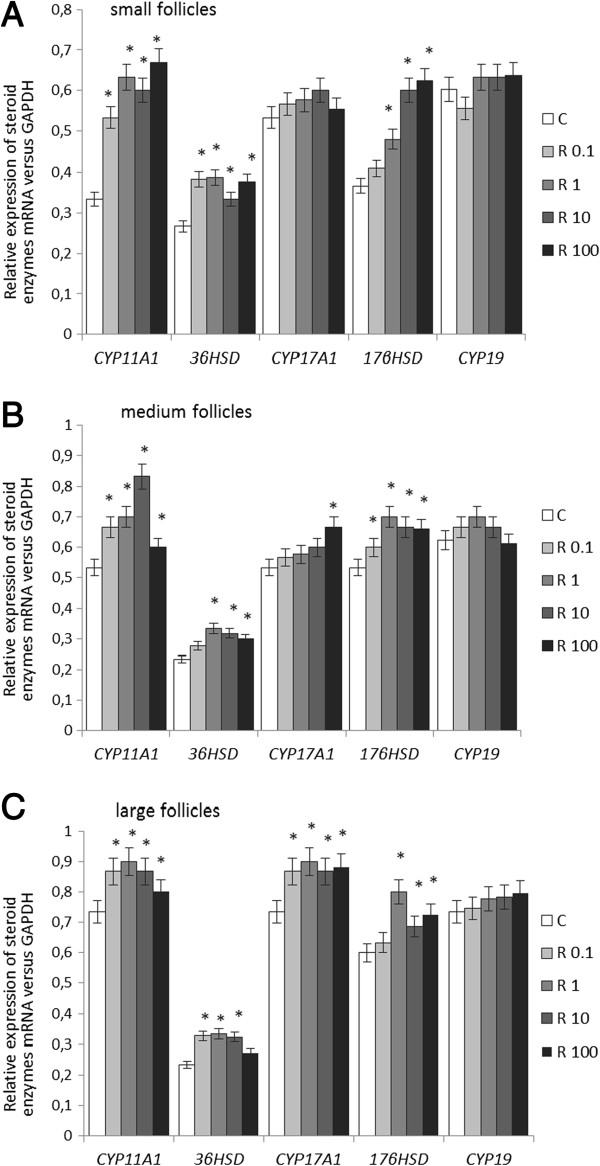
Effects of recombinant human resistin (0.1, 1, 10, and 100 ng/ml) on the mRNA expression of steroidogenic enzymes (i.e., CYP11A1, 3βHSD, CYP17A1, 17βHSD, and CYP19A1) in A) small, B) medium and C) large ovarian follicles. The expression of mRNA has been determined by real time-PCR. The expression of each gene was normalized to the expression of GAPDH. Real time PCR experiments were performed three independent times. In each experiment six ovaries from three different animals were selected. Data were plotted as mean±S.E.M. Statistical significance is indicated by * P < 0.05.